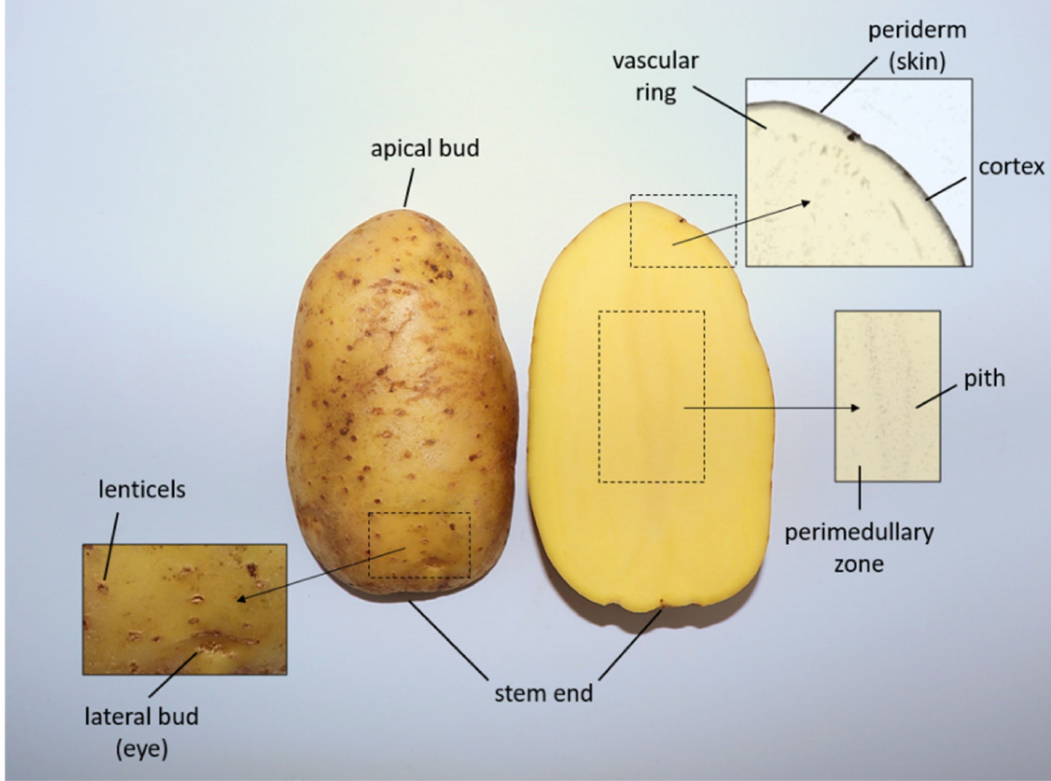
Figure 2. Structure of a potato tuber of the bernina variety (own illustration, terminology based on